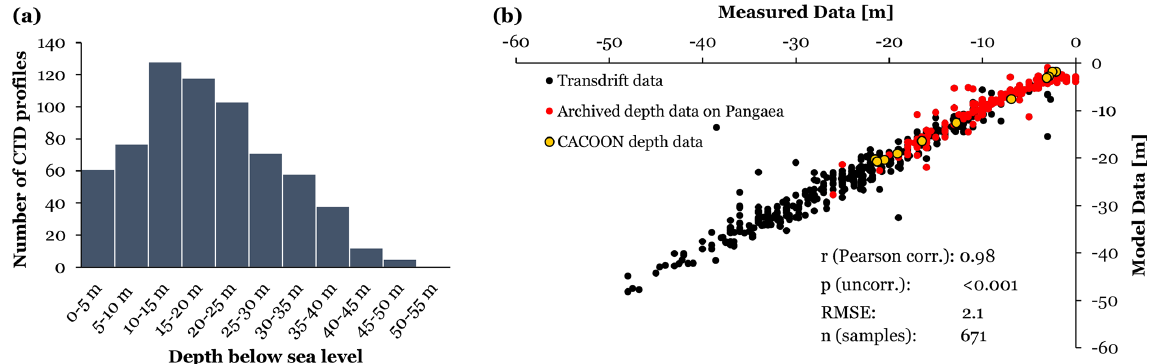
Figure 6. Validation data for the Topo to Raster model (50m) of the Lena Delta region. (a) Histogram showing the depth distribution (5m depth intervals) of the CTD data in the Lena Delta region. (b) Correlation between the CTD data (671 points) and the modeled values (TTR 50